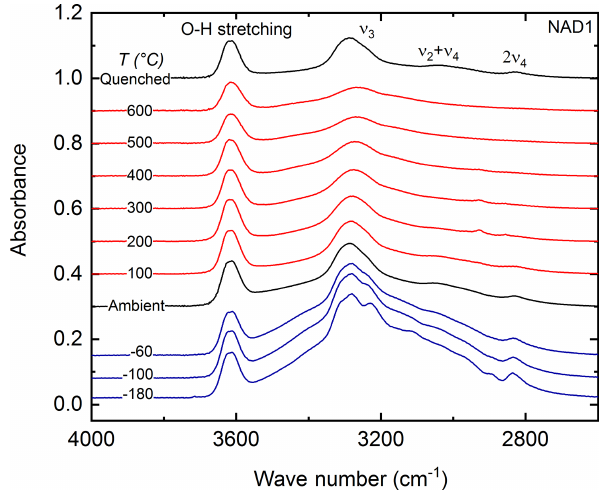
Figure 3. T -dependent ( − 180 to 600 ◦ C) FTIR spectra of sample NAD1 at ambient P . OH stretching vibration and N–H antisym- − ν metric stretching vibration (NH + 3 ) are observed in this spec- 4 tral range. Spectra are vertically offset for clarity. Red: spectra with heating; blue: spectra with cooling; black: at ambient conditions and quenched spectra. Figure 4. (a) Peak position of NH 4 − ν 3 stretching vibration of sam- ple NAD1 with decreasing T (after correction for thin-ice-film con- tribution; see text) showing splitting into three different peaks and with increasing T showing a shift to lower wave numbers. Changes in peak positions with T , i.e. (d ν/ d T ) values, are shown with es- timated standard deviations of the last digit in parentheses. (b) De- crease in integral absorbance of ν 3 with heating; integral absorbance of NH 4 − ν 3 peaks with cooling is the summation of the three split peaks. The error bars are shown; otherwise they are within the sym- bol size. Black solid lines are linear fits to the data. Grey shaded area represents the 95% confidence interval of the data. Squares repre- sent the main NH 4 − ν 3 peak and the summation of the three split peaks with cooling; triangles represent the two additional peaks re- sulting from splitting of this main vibration with decreasing T